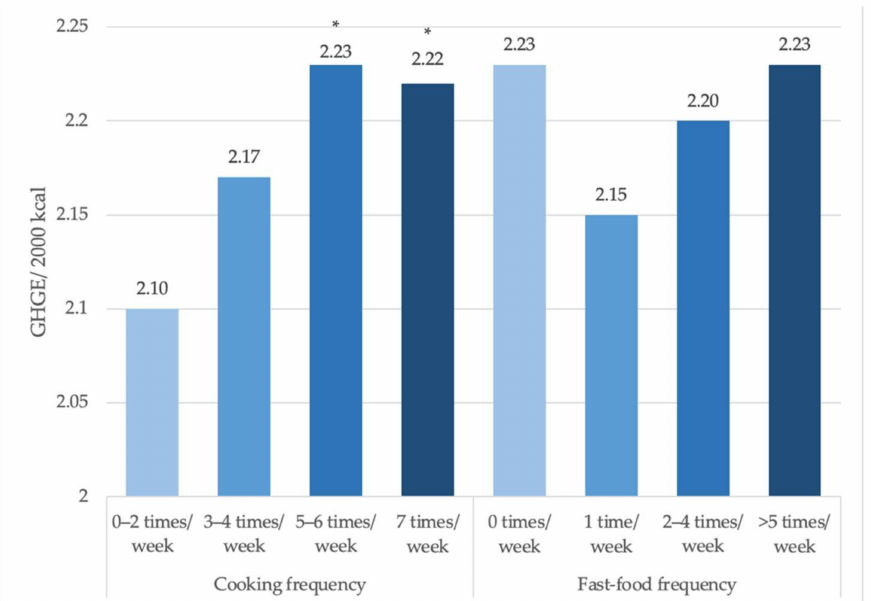
Figure 1. Predicted daily GHGE per 2000 kcal based on frequency of cooking dinner at home and eating out at fast food restaurants (NHANES 2007–2010). Note: Based on post-estimation margins following separate GLM models with gamma family and log link that controlled for age, sex, race/ethnicity, income, education, employment status, and household size. * p < 0.05. p -trend for cooking frequency = 0.03; p -trend for fast-food consumption =